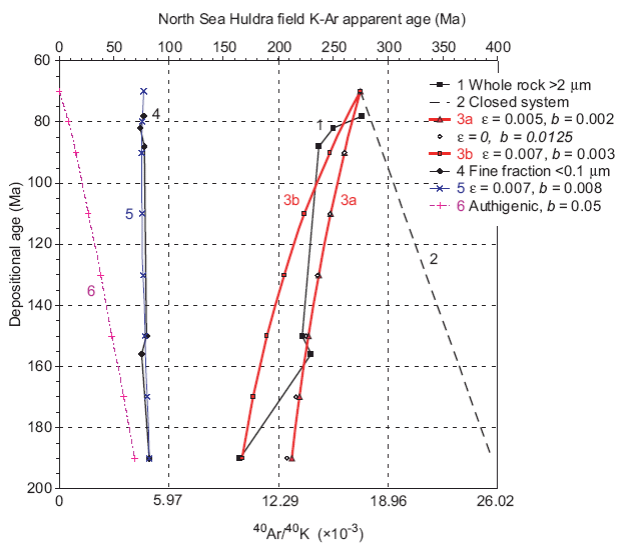
Figure 5. The K-Ar apparent ages of the coarse- (line 1) and fine-grained size (line 6) fractions from the North Sea section [22]. For the coarse-grained fraction: calculated K-Ar dates if the particles were a closed system (line 2); data points bracketed by the two-process model at different rates of 40 Ar loss ( ε Ma − 1 ) and K gain (b Ma − 1 ) (curves 3a and b); because of a relatively small decrease in the K-Ar apparent age over a long period of time, the two-process curve 3a that shows 40 Ar loss and K gain is very close to the one-process result of K gain only (b = 0.0125). For the fine-grained fraction: 40 Ar escape and K addition (curve 5) approximate the nearly constant K-Ar apparent age of 77 Ma of the depositional age 70 Ma. See Equation (A4b) in the Appendix